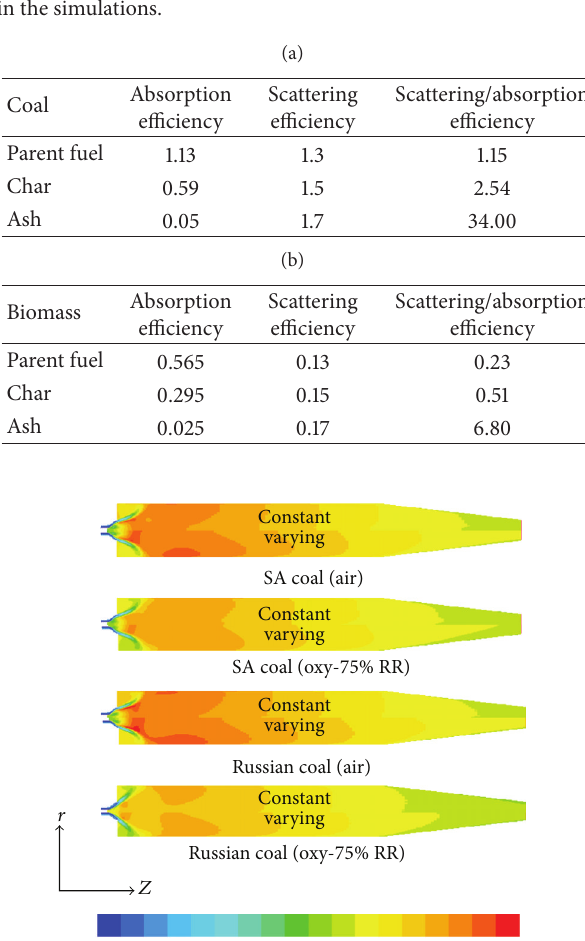
Table 1: Coal and biomass radiative property variations employed in the simulations.